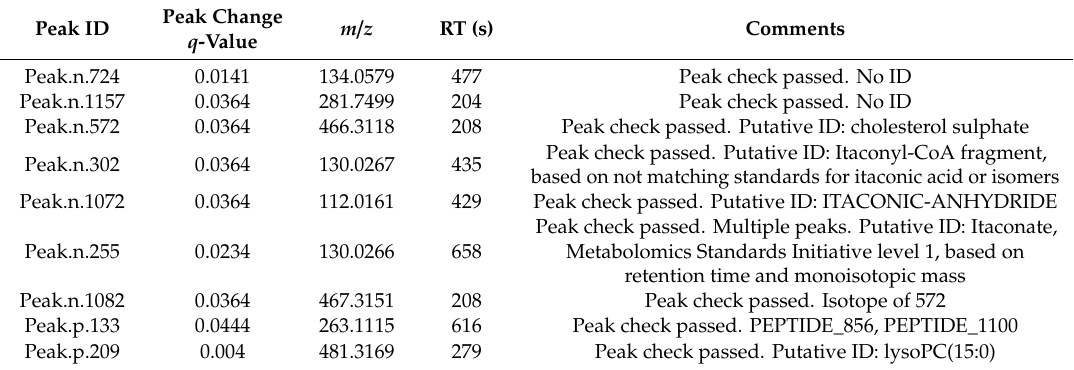
Figure 2. Scatter plots demonstrating change in DAS44 between baseline and 3 months vs. change in log2 peak intensity of 8 putative metabolites. The Itaconate peak (Peak 255) has been identified. Peaks 1072 and 302 have been given putative identities of Itaconate anhydride and Itaconyl-CoA, respectively.